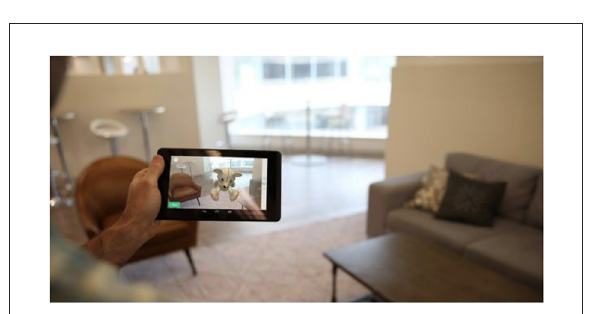
FIGURE3 Illustration of the Augmented Reality (AR) task in the Altoida DNS test. During the AR test, the subject is asked to place and find three virtual objects in the room. To do so, the subject is required to walk around the room holding a tablet or smartphone device in front of him/her. While doing so, the camera of the device records the environment and displays it back to the user on the screen, augmented with virtual objects (in this illustration, a teddy bear). The user needs to place the objects on flat surfaces and later recall their position by walking back to that